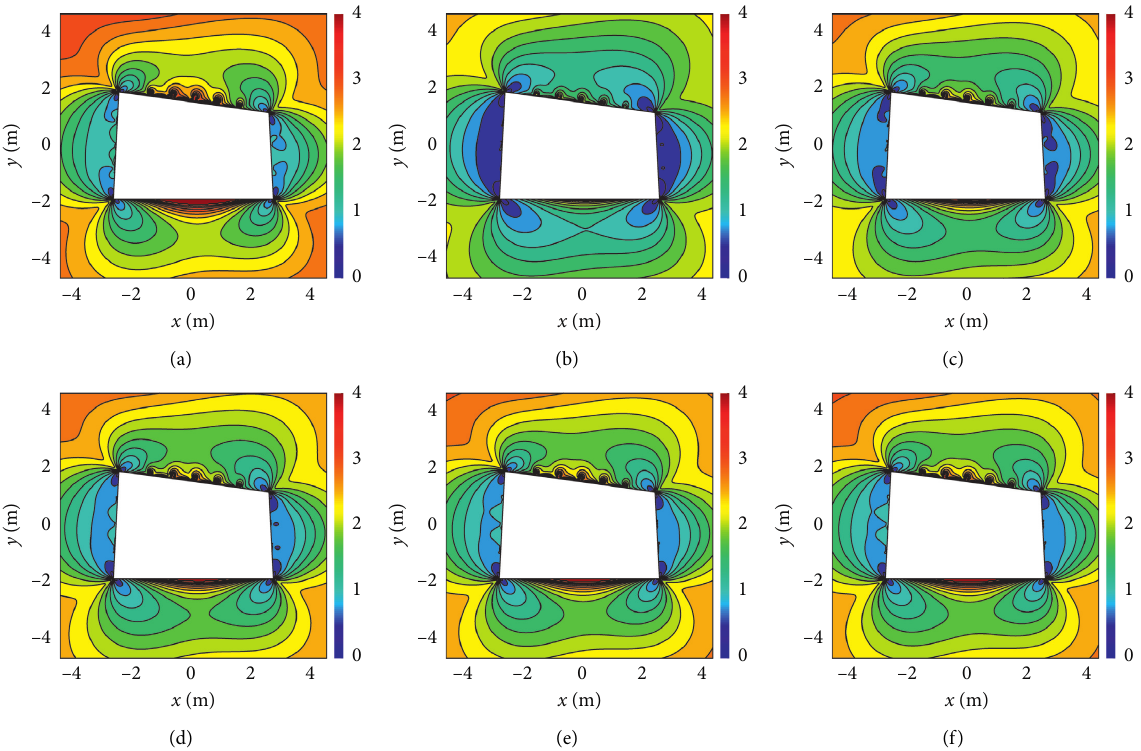
Figure 10: Contour map of SRSI of IRMR in the end anchoring zone at different distances from the working face. (a) l � 30m. (b) l � 60m. (c) l � 100m. (d) l � 140m. (e) l � 200m. (f) l � 300 Figure 14. The surface deformation rate is shown in Fig- ure 15. In the figure, stations 1, 2, and 3 are arranged in the full-length anchoring bolt support zone, and stations 4, 5, and 6 are arranged in the end anchoring bolt support zone.